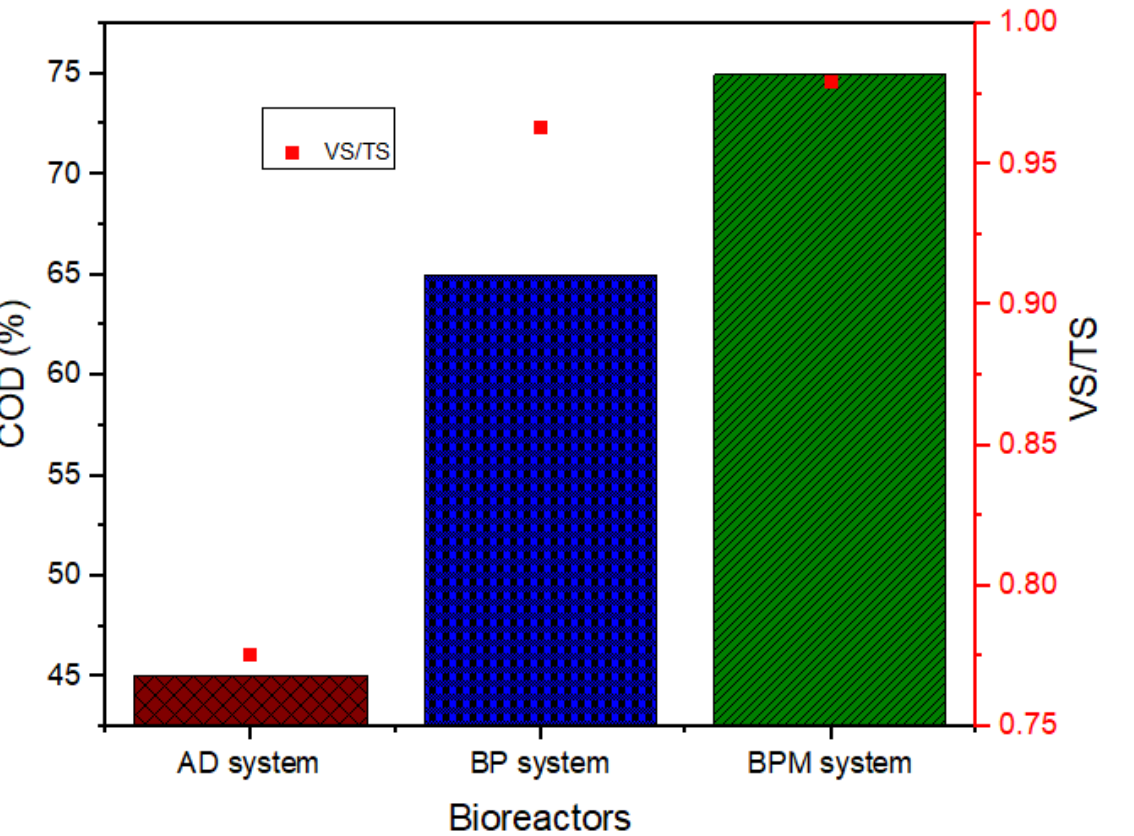
Figure 3. Bioreactor performance for COD removal (%) and VS/TS reduction ratio after 30 days of incubation.